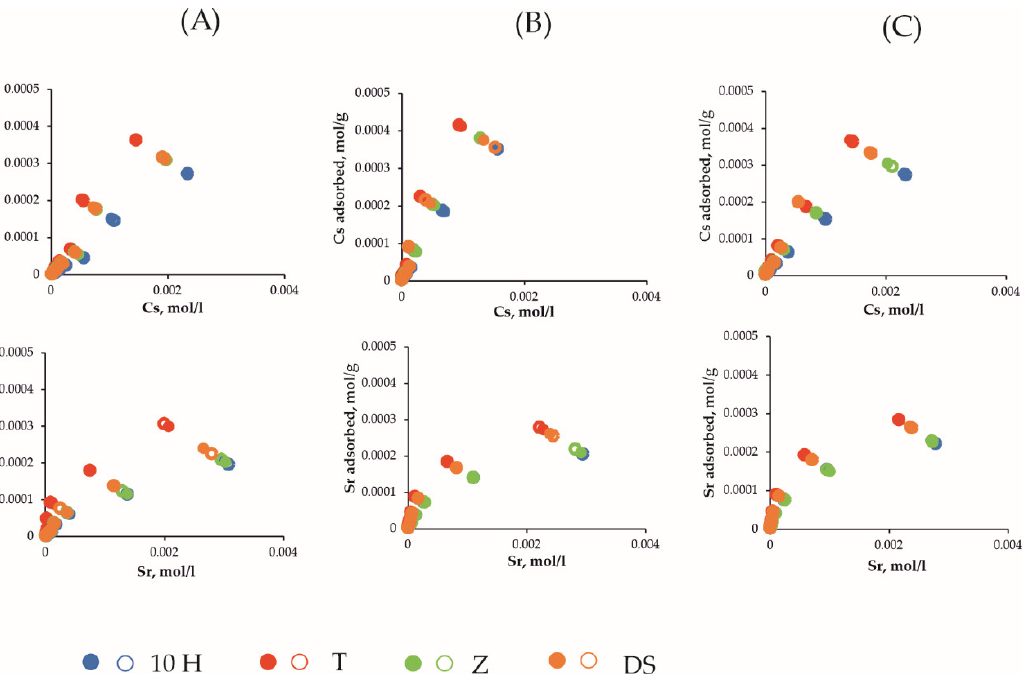
Figure 3. Adsorption isotherms of Cs(I) and Sr(II) on bentonites 10H, T, Z, and DS in experiments with the initial solution at pH 3 ( A ), 7 ( B ), and 10 ( C ). Empty and filled icons are replications of the experiment.